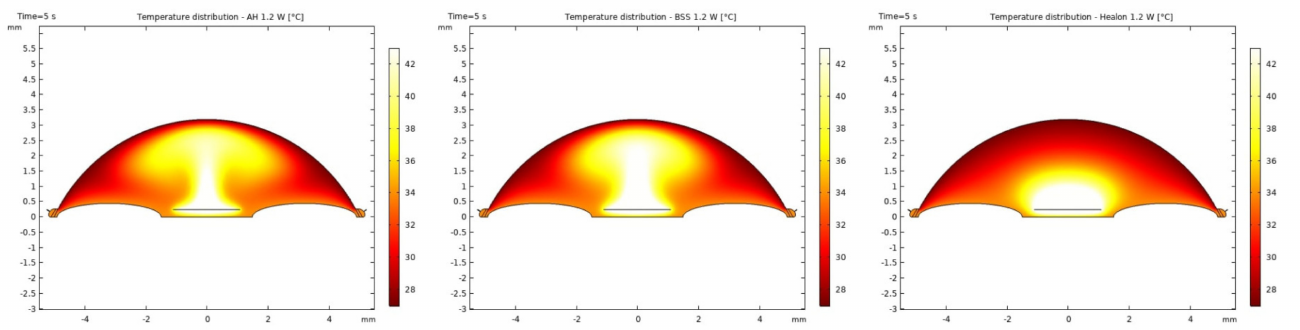
Figure 5. Velocity distributions with AH, BSS and Healon after 5 s of 1.2 W impulse.